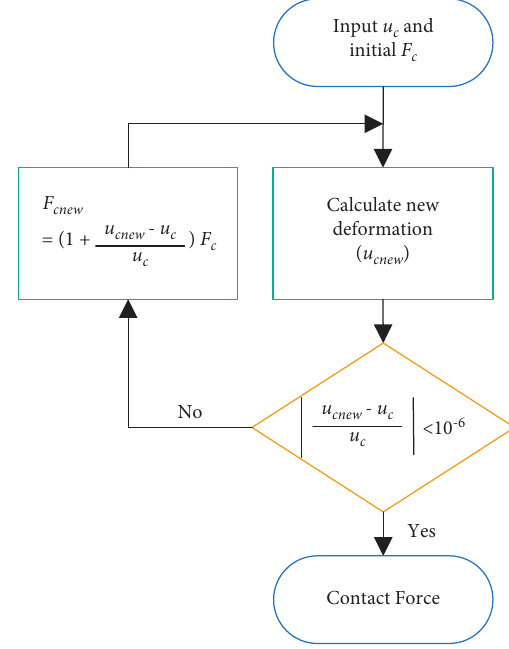
Figure 7: Calculation flow of contact